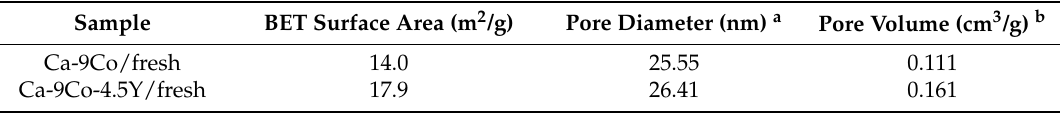
Table 1. Structural properties of the fresh catalyst/sorbents.